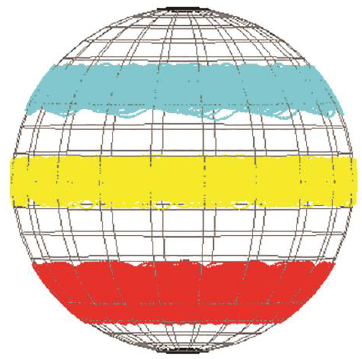
Figure 1. Spatial evolution of the States of Polarization (SOPs) in a twisted fiber.